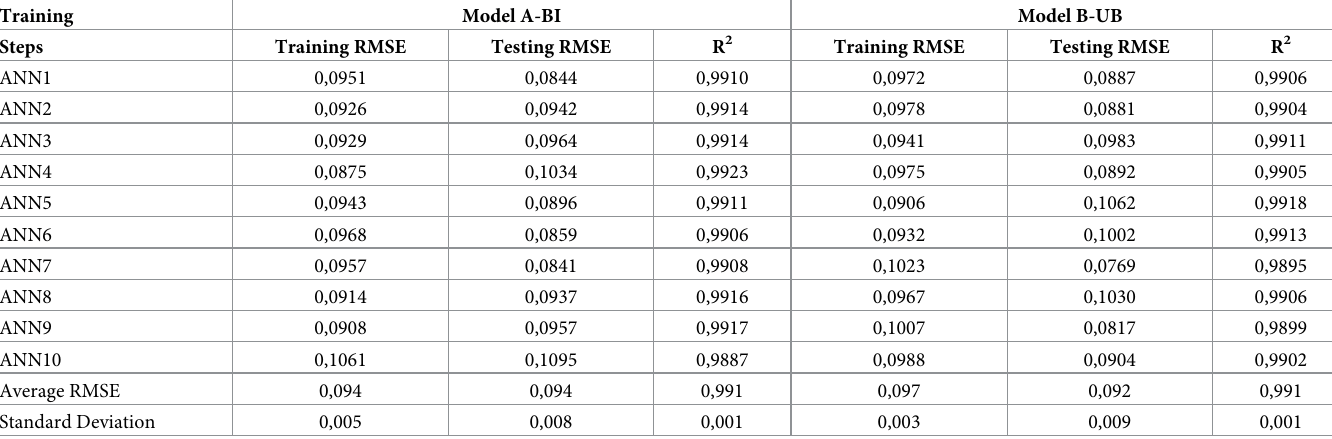
Table 4. ANN analysis average RMSEs and R 2